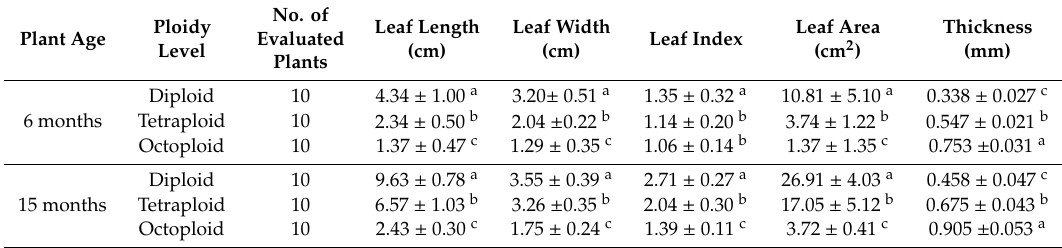
Ten plants of each ploidy level were included in the morphology measurement, and mean values ± SE in the same column followed by di ff erent lower letter are significantly di ff erent at p < 0.05 according to Duncan’s